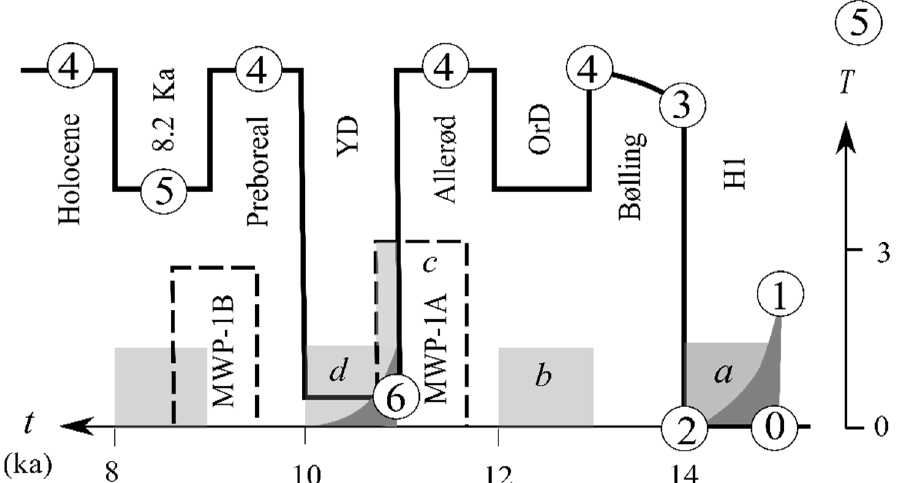
Figure 10. The anatomy of deglaciation corresponding to that of Figure 9 with the observed events labelled. The light shades are the square-wave freshwater flux of a 2-ky period with letters a–d corresponding to the meltwater events identified in [83]. The dark shades indicate the sea-ice covers induced by ocean cooling.